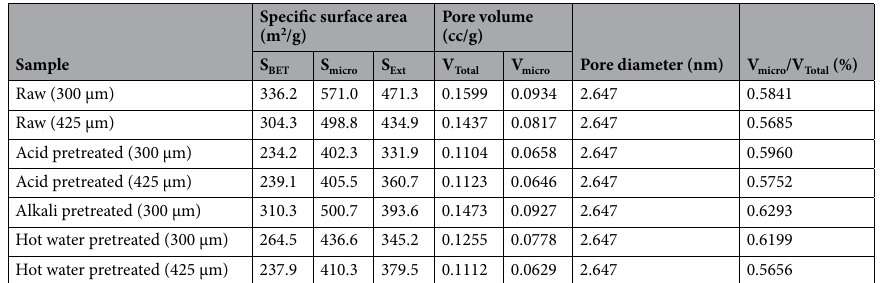
Table 7. Pore characteristics of corn cobs biomass (raw and pretreated).